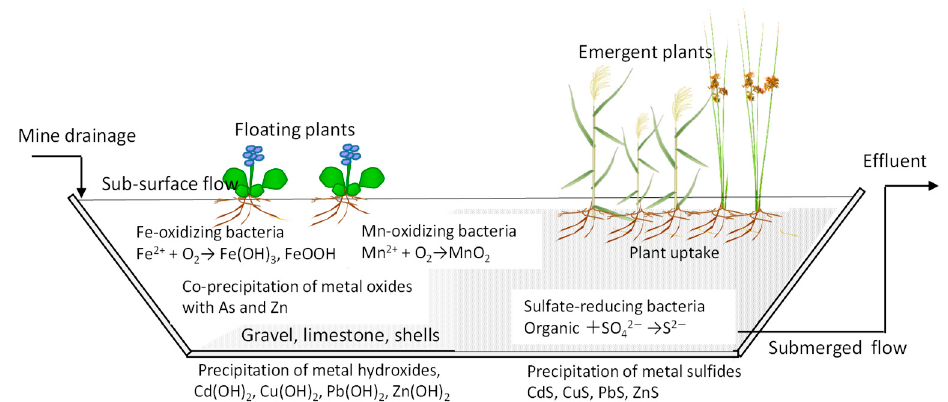
Figure 1. Conceptional mechanisms for metal removal in constructed wetlands.